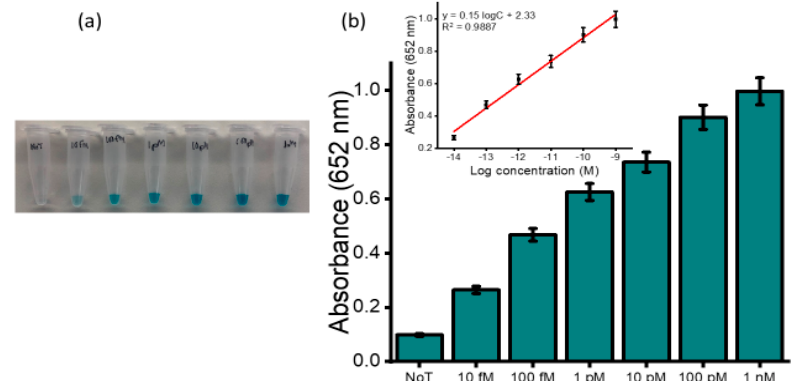
Figure 5. ( a ) Picture of the naked-eye detection corresponding to the designated starting concentration of HOTAIR sequences ranging from 10 fM to 1.0 nM in spiked plasma samples. ( b ) Corresponding bar diagram of the absorbance at 652 nm for the designated concentrations of HOTAIR. Inset, linear calibration plot showing concentration–current density relationship. Error bars represent the standard deviation of three repeated experiments.